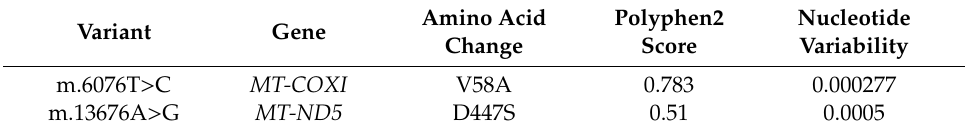
Table 1. Analysis of CTR2 mtDNA